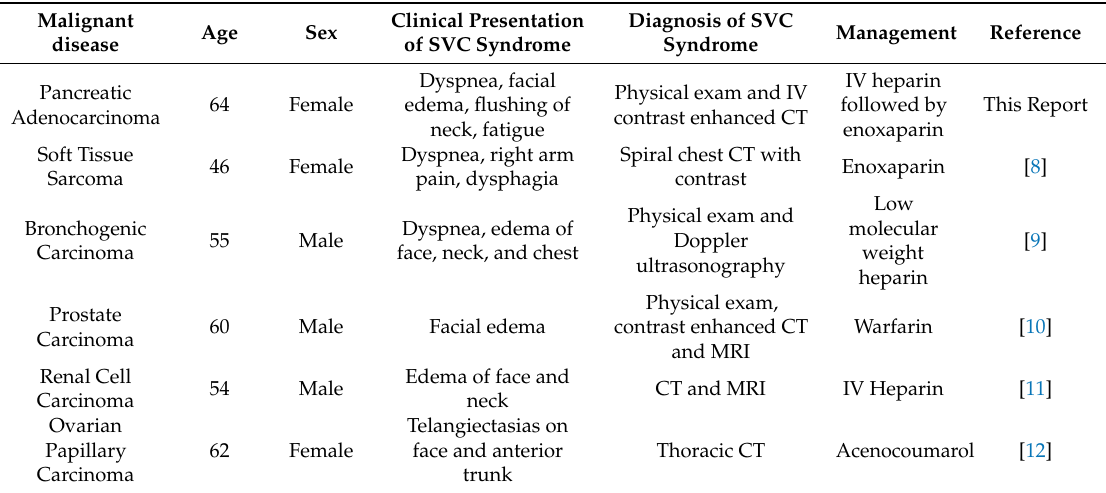
Table 1. SVC syndrome caused by intravascular thrombosis in association with